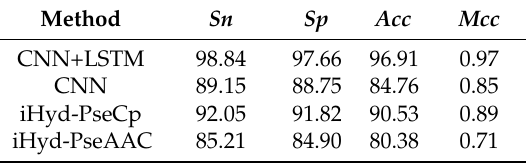
Table 4. A comparison of predictors for identifying hydroxylysine sites on Dataset 4.